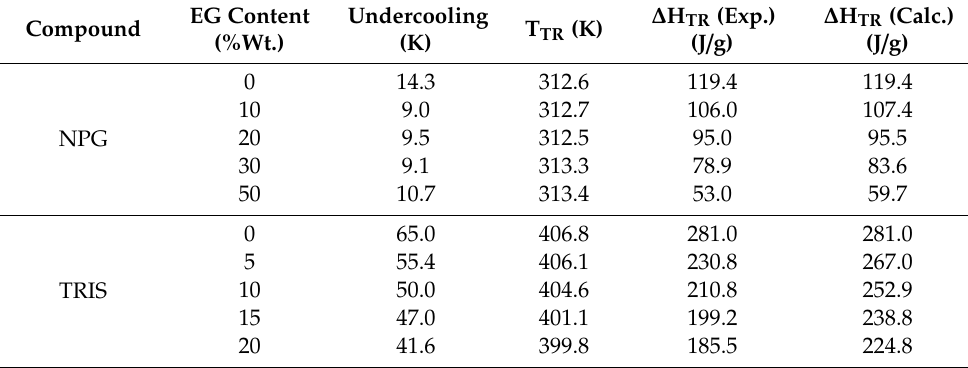
Table 7. Summary of the influence of EG microparticles on the solid-solid transitions of pure NPG and TRIS: T TR = solid-solid transition temperature at equilibrium; ∆ H TR = measured enthalpy of solid-solid transition on heating (referred to the total mass of the composite); ∆ H TR (cal.) = enthalpy of the solid-solid transition calculated by applying the rule of